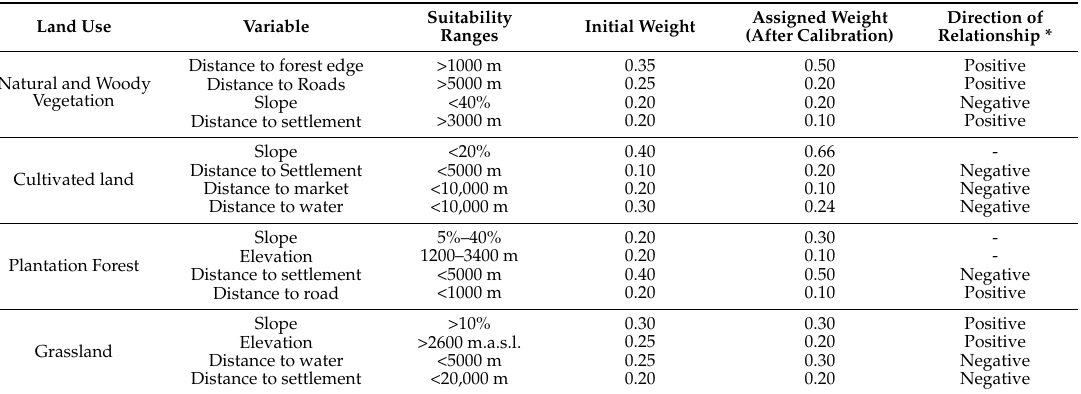
Table 6. Suitability rule-sets.